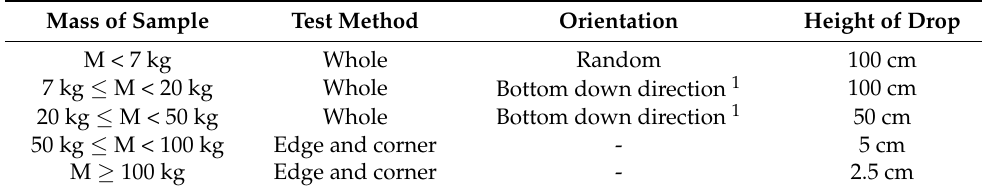
Table 3. Specifications of the drop test methods in IEC 63056-2020 (Adapted from [71]). Mass of Sample